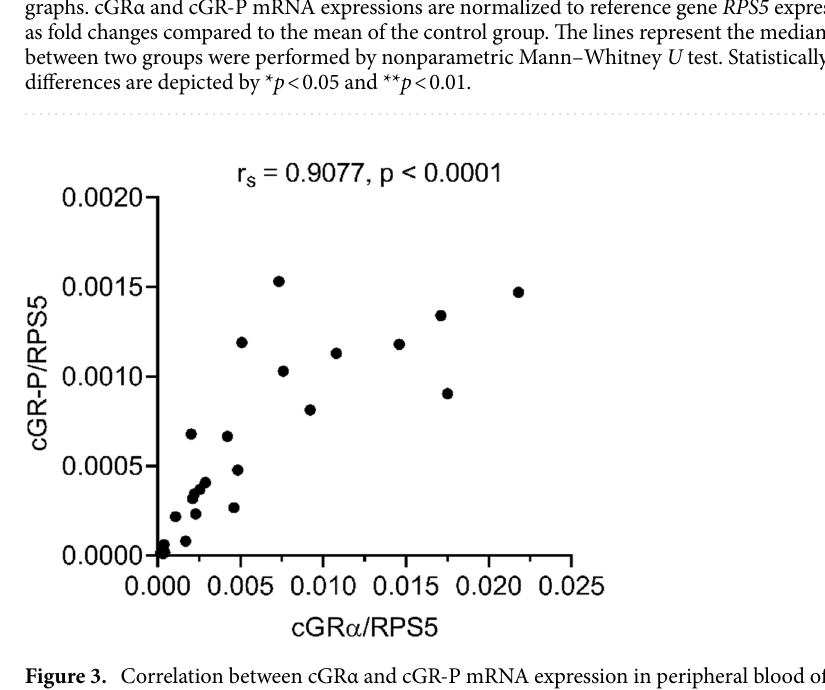
Figure 3. Correlation between cGRα and cGR-P mRNA expression in peripheral blood of SIRS patients at hospital admission. cGRα and cGR-P mRNA expressions are normalized to reference gene RPS5 expression. Correlation analysis was performed by Spearman’s rank test and p < 0.05 was considered statistically